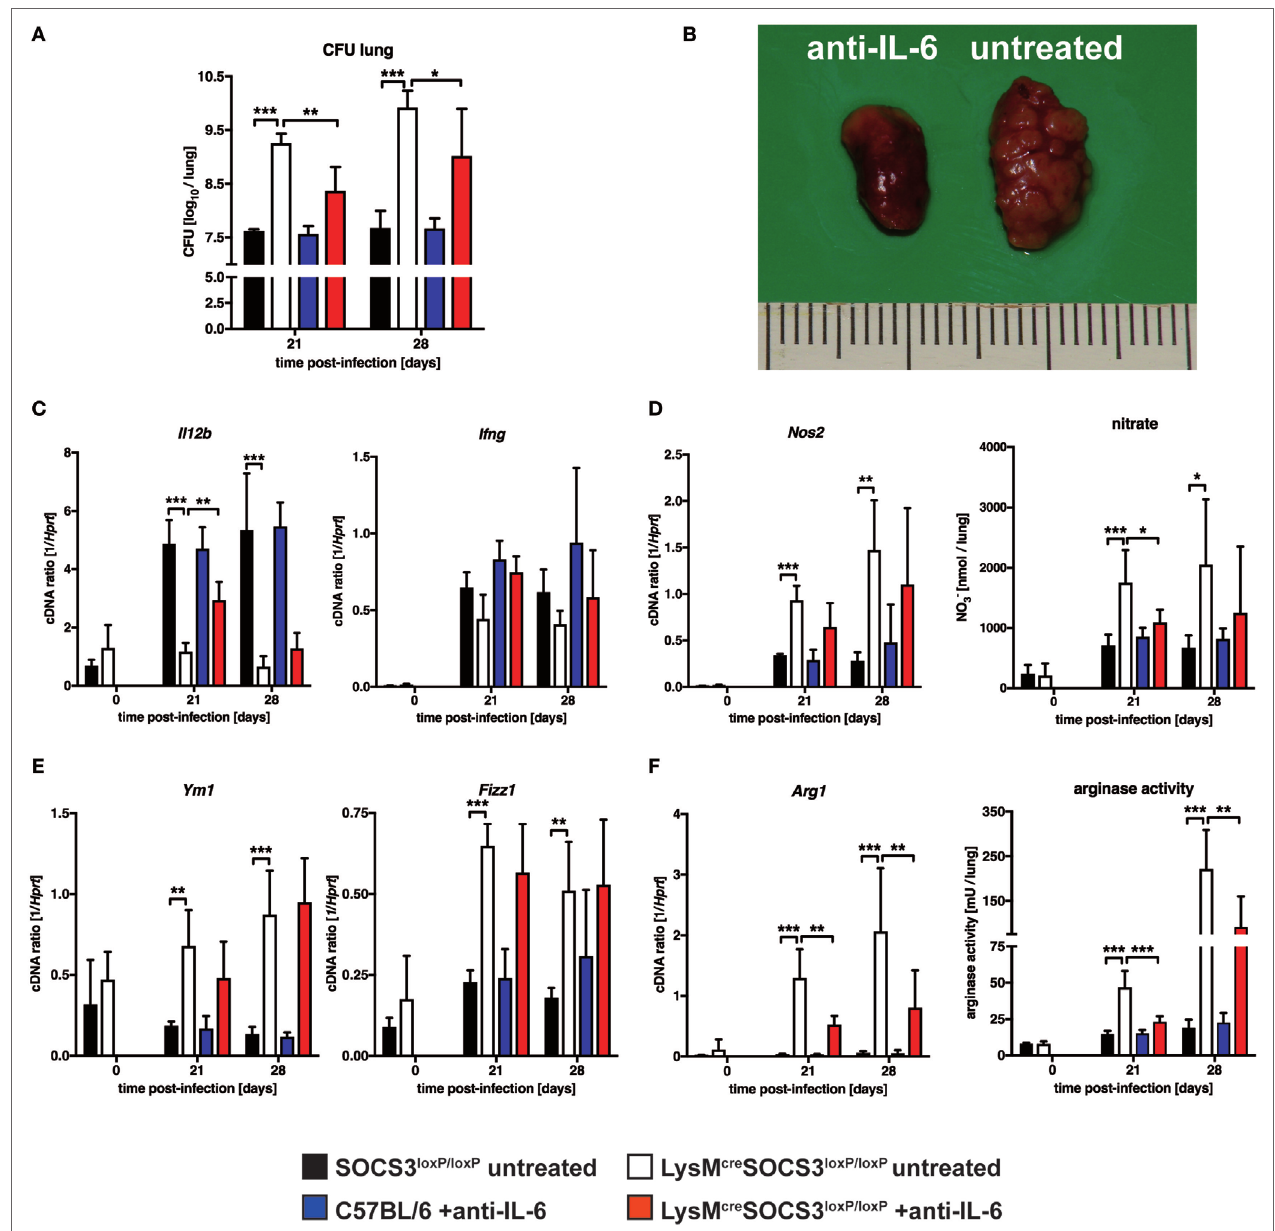
FigUre 6 | Interleukin (IL)-6-dependent macrophage responses, susceptibility and pathology in Mtb -infected LysM cre SOCS3 loxP/loxP mice. Control (C57BL/6 and Cre-negative SOCS3 loxP/loxP ) mice and LysM cre SOCS3 loxP/loxP mice were infected with approximately 1,000 CFU Mtb via the aerosol route. Two groups, C57BL/6 and LysM cre SOCS3 loxP/loxP mice, were i.p. injected twice a week with 250 µg of a monoclonal rat anti-mouse IL-6 antibody. Two other groups of cre-negative SOCS3 loxP/loxP and LysM cre SOCS3 loxP/loxP mice were left untreated. Lungs were removed at the indicated time points. (a) For mycobacterial colony enumeration assays, aseptically removed lungs were weighed, transferred into PBS containing a proteinase inhibitor cocktail and homogenized. Tenfold serial dilutions of organ homogenates were plated and colonies were counted three weeks later. (B) At 28 days of infection, photographs of removed lungs were taken. (c) Gene expression of Il12b and Ifng in lung homogenates was determined by qRT-PCR. (D) Gene expression of Nos2 in lung homogenates was determined by qRT-PCR. To detect RNI, NO 3 was converted into NO 2 after deproteination of homogenates. Following the addition of Griess reagents, the content of NO 2 was determined by photometric measurement. (e) Gene expression of Ym1 and Fizz1 in lung homogenates was determined by qRT-PCR (F) Gene expression of Arg1 was determined by qRT-PCR. To determine arginase activity, the enzyme was activated and arginine hydrolysis was conducted after the addition of l -arginine. The reaction was stopped and the urea concentration was determined as a degree of arginase activity. Data represent means ± SD of at least five mice per group. Statistical analysis was performed as described in experimental procedures defining differences between control and LysM cre SOCS3 loxP/loxP mice or untreated and treated animals as significant (* p ≤ 0.05; ** p ≤ 0.01; *** p ≤